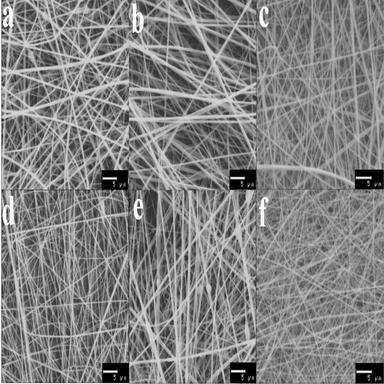
SEM micrographs of a) Av/PVP6 wt%, b) Av/PVP8 wt%, c) Av/PVP10 wt%, d) AvAc/PVP 6 wt%, e) AvAc/PVP 8 wt%, f) AvAc/PVP 10 wt% nanofiber scaffolds.